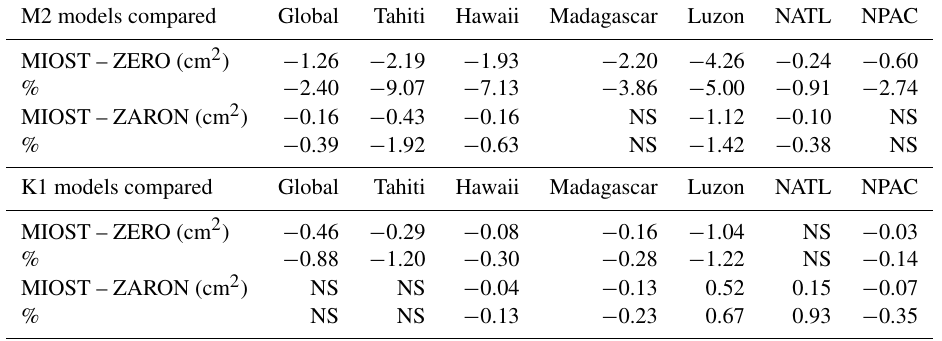
Table 1. Variance reduction for Cryosat-2 crossovers differences (cycles 96–124) when using the new MIOST internal tide solution and either a zero IT correction or the Zaron (2019) correction for M2 and K1 frequencies, in cm 2 and %. Values less than 0.1% are not significant (NS). M2 models compared Global Tahiti